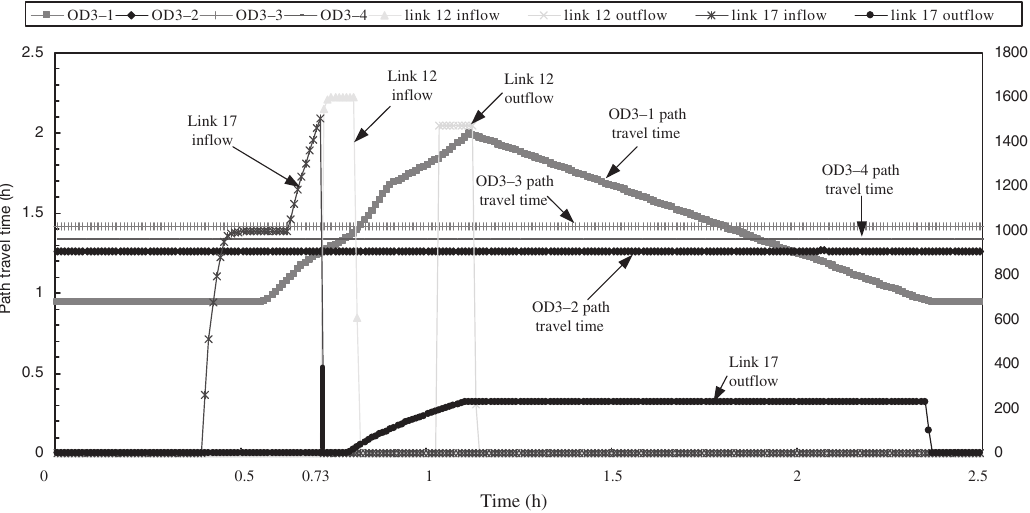
Fig. 6. Truck flow and instantaneous travel time on Links 12 and